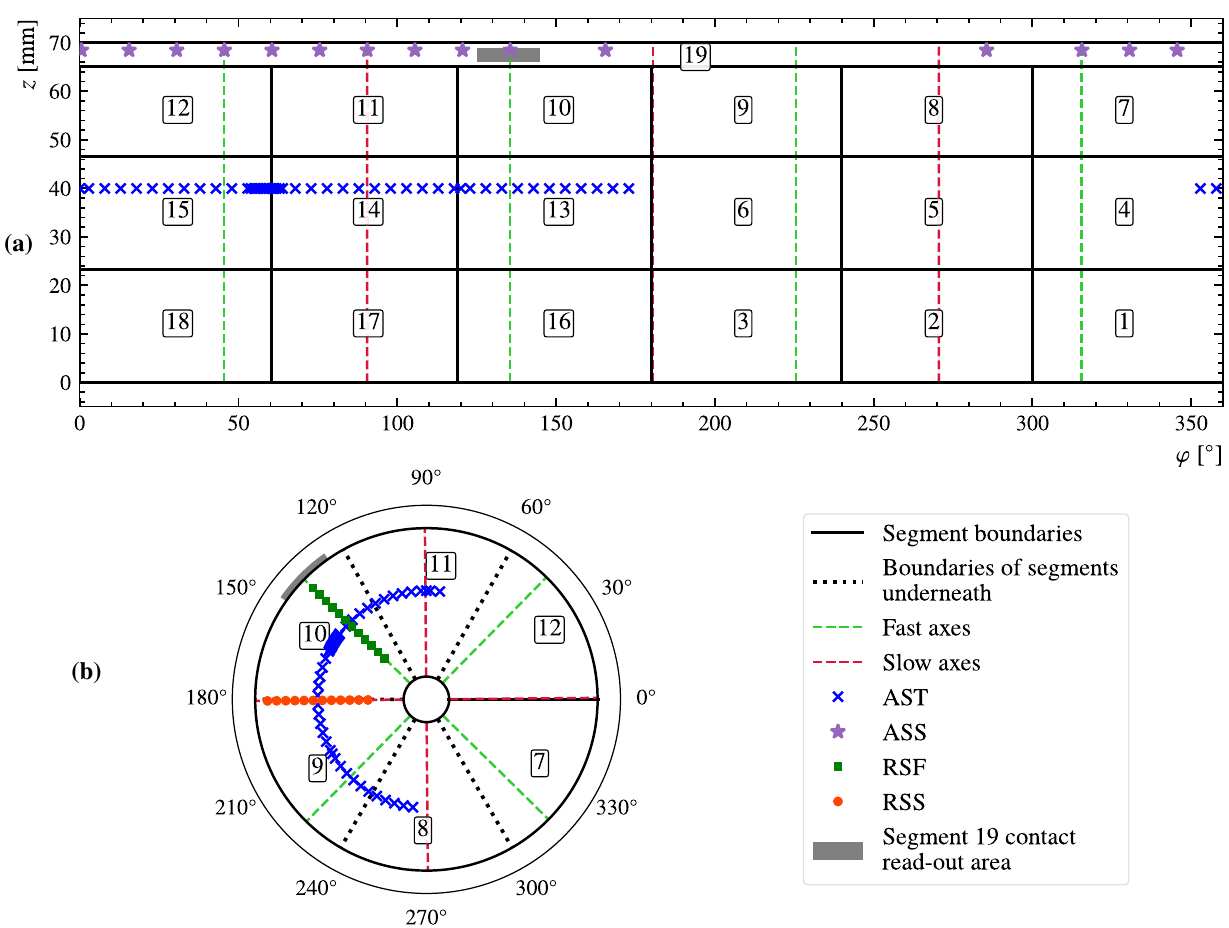
Fig. 3 a Side view: the segment structure of the mantle of Super- Siegfriedwithdimensionsandreferencecoordinatesystem. b Topview: the positions of the measurements on the top surface are marked. Also